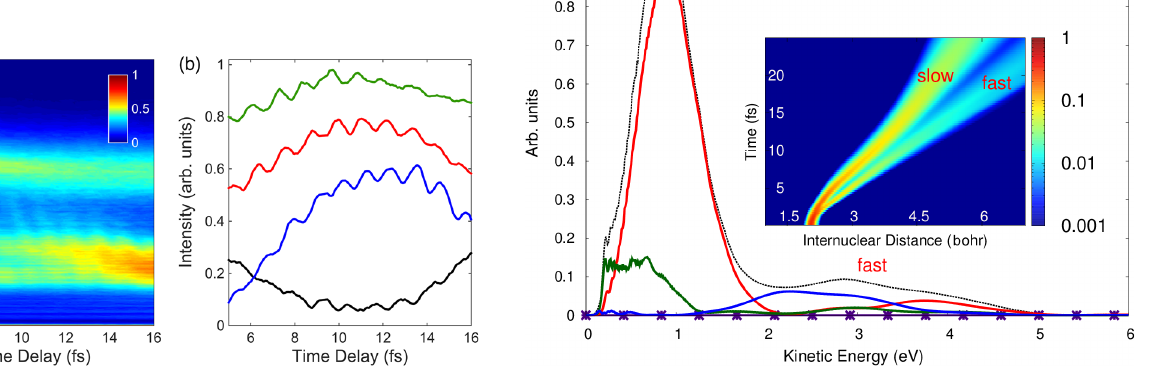
the retrieved 3D momentum distribution (inset) within 20° around the laser polarization axis (white dashed line). (b) N þ kinetic energy spectra as a function of the delay between the XUV pump pulse and the NIR/VIS probe pulse.